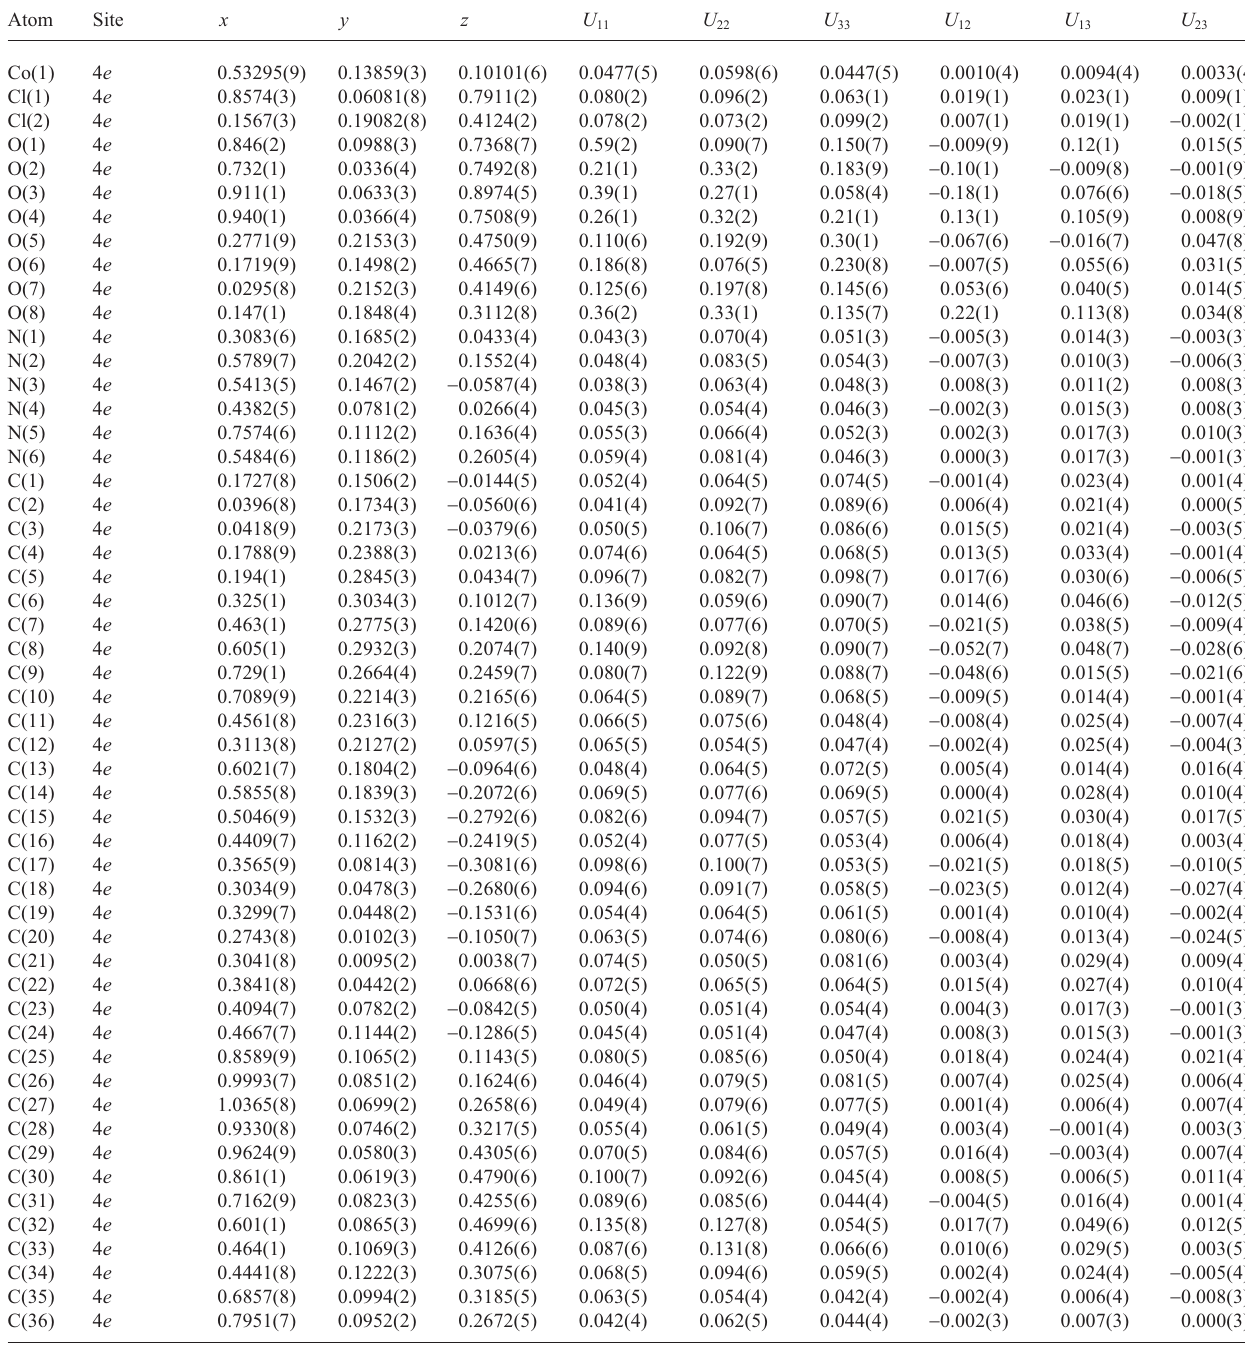
Table 3. Atomic coordinates and displacement parameters (in Å 2 )